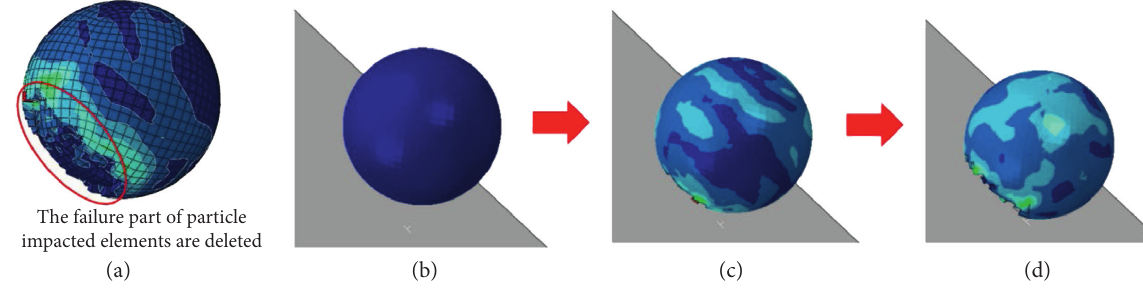
Figure 9: Impact effect diagram of Model